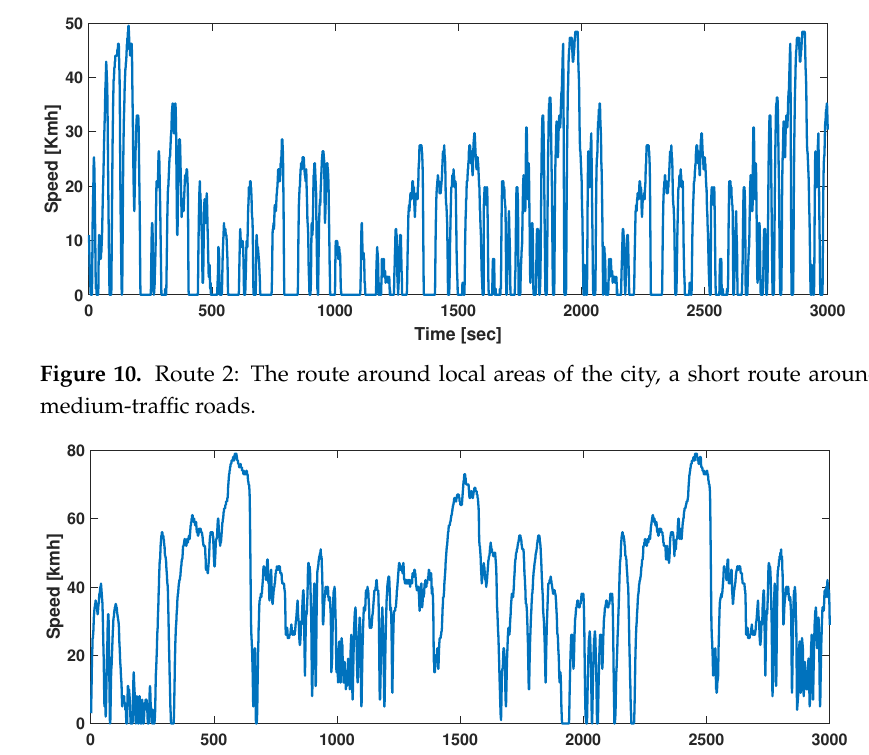
Figure 9. Route 1: The route of the EV between two cities on the highway.